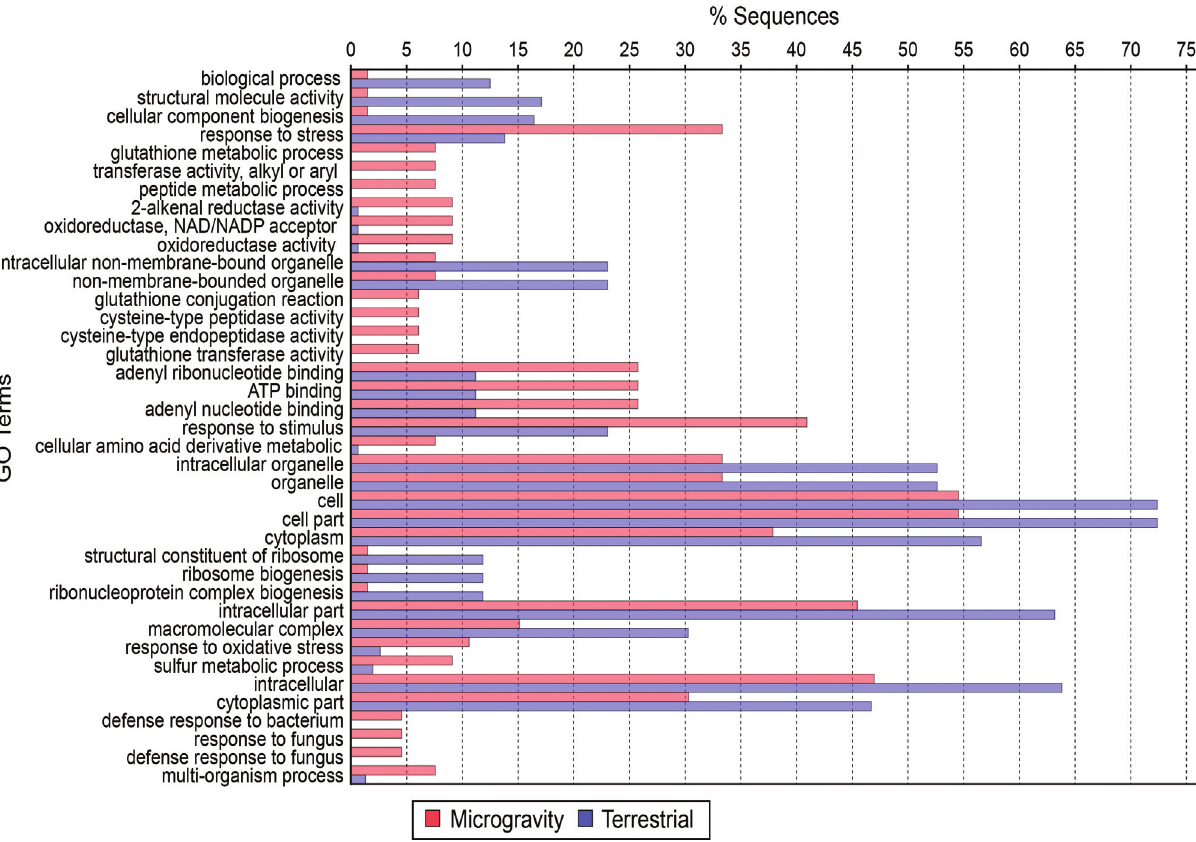
Figure 6 - Fisher’s Exact Test (conducted in Blast2GO) comparison of the enrichment of GO terms in the microgravity and terrestrial libraries, with cor- rection for multiple testing.